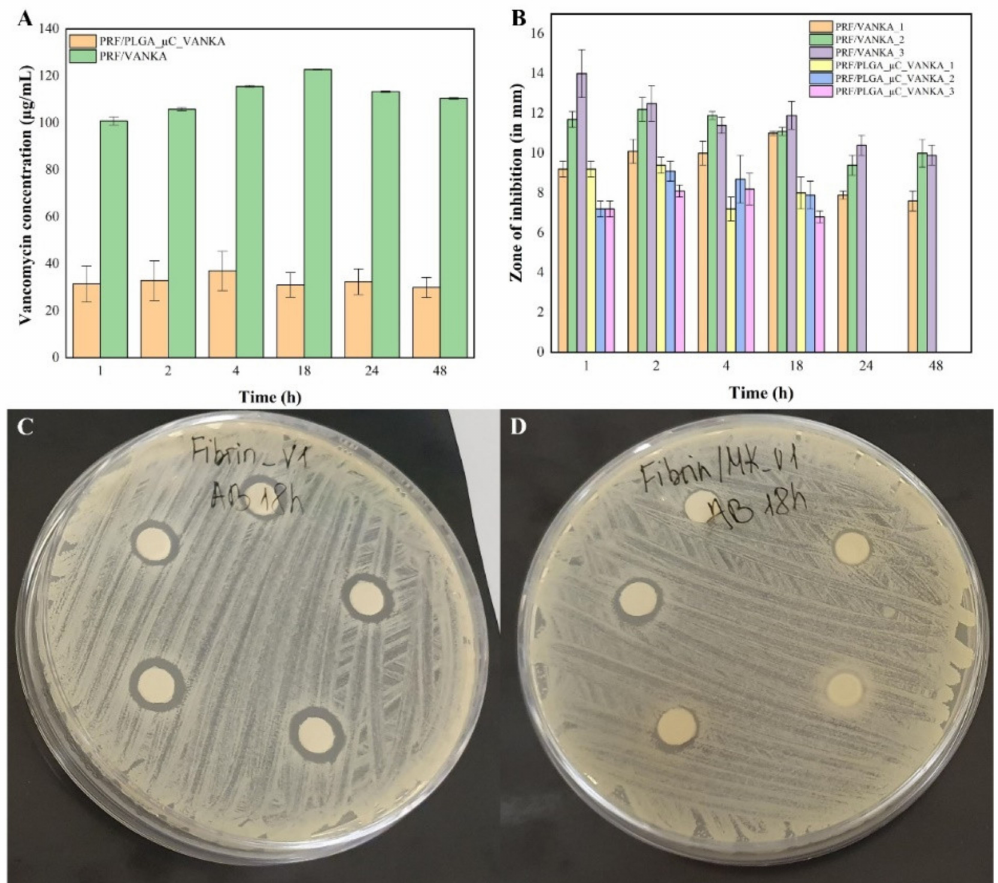
Figure 13. Antibacterial properties of sample incubation medium at different time points: ( A ) detected VANKA concentra- tions at sample incubation medium at different time points; ( B ) inhibition zones of disks impregnated with sample incubation medium at different time points; ( C ) sterile areas around the disks that were impregnated with PRF/VANKA sample incu- bation medium at 18-h time point; ( D ) sterile areas around the disks that were impregnated with PRF/PLGA_ µ C_VANKA sample incubation medium at 18-h time point. The diameter of the petri dishes is 8.5